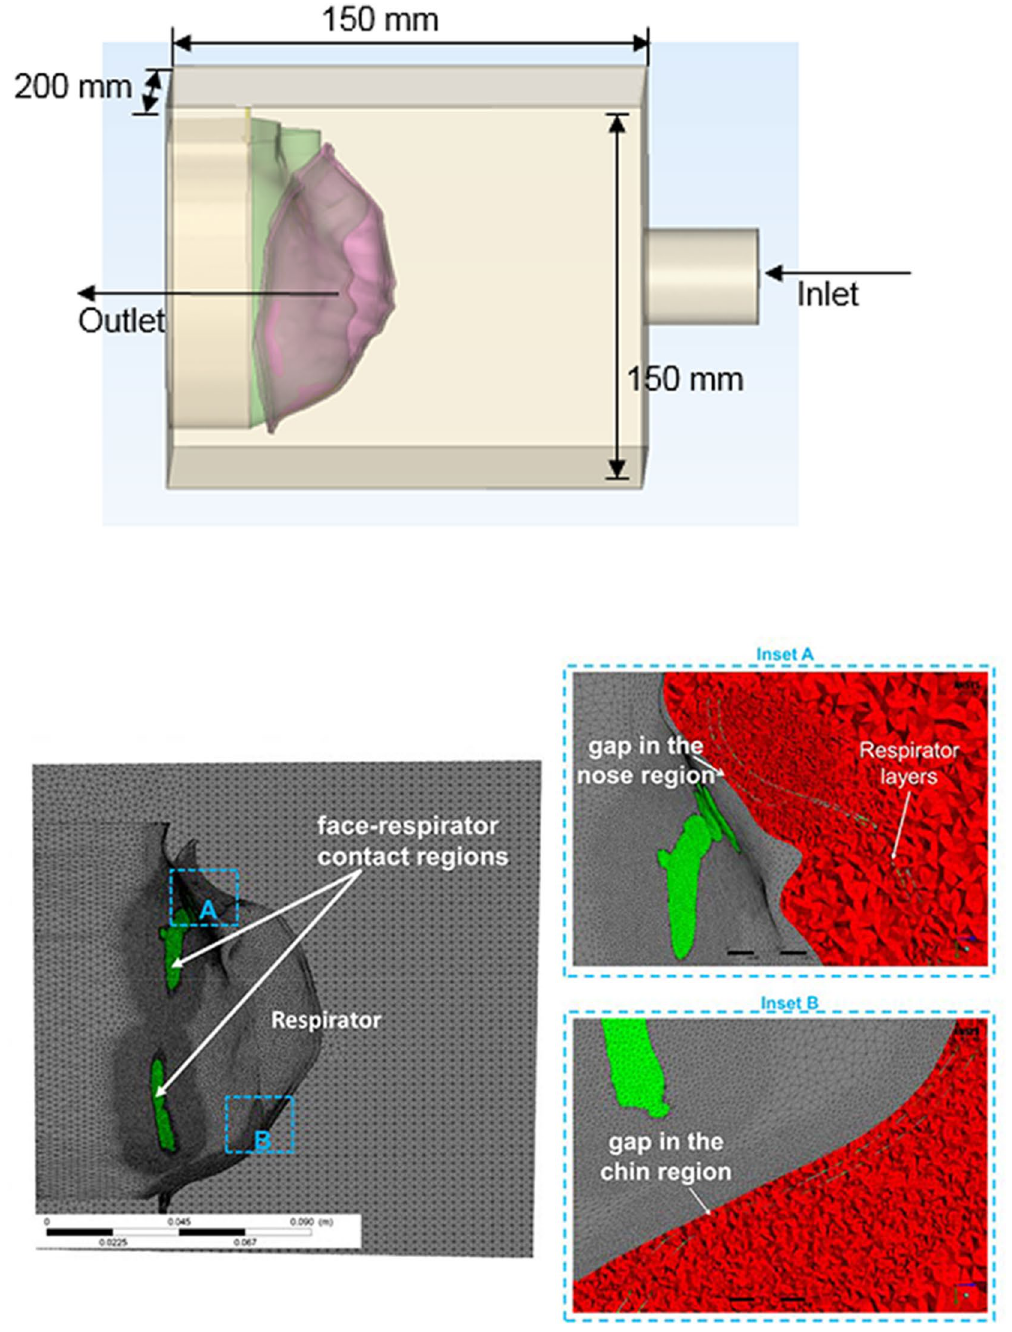
Figure 3. ( A ) CFD geometry of headform and respirator inside the chamber, ( B ) CFD mesh (sectioned) with insets ( A ) and ( B ) showing the gaps in the nose and chin